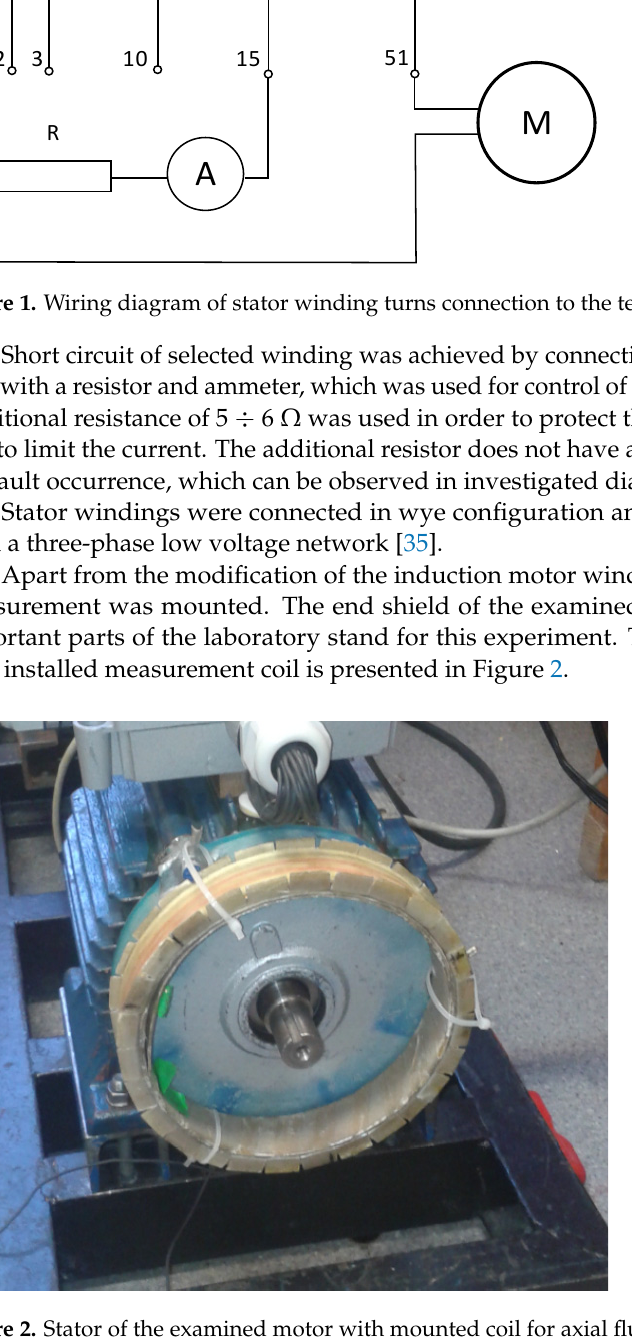
Figure 2. Stator of the examined motor with mounted coil for axial flux measurement. The method of identifying inter-turn faults presented in the paper allows for an in- depth analysis of the results obtained from measurements. During the tests the registered parameter values were used, which were obtained from laboratory measurements of the induction motor behaviour and carried out on the laboratory stand described in this